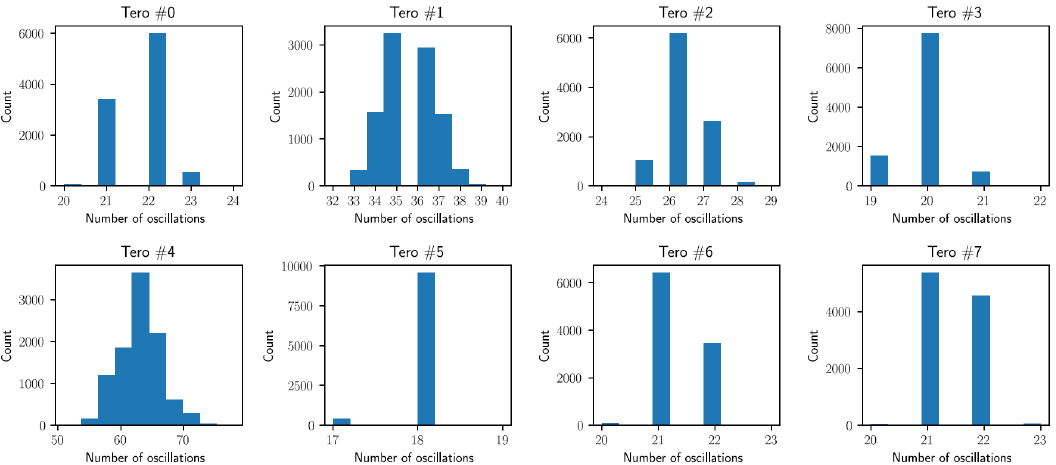
Figure 8. Number of oscillations histogram for 10 5 trigger events for Transition Effect Ring Oscillator (TERO) True-Random Number Generator